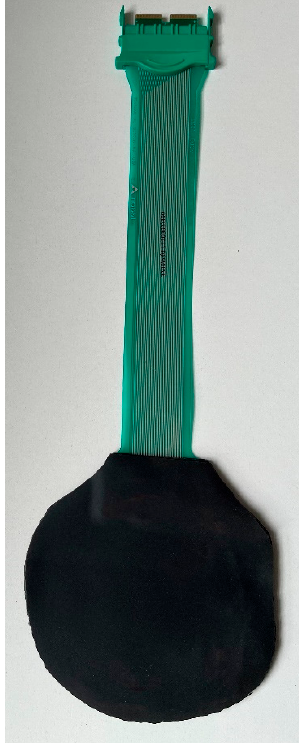
Figure 3. Prepared sensor foil.